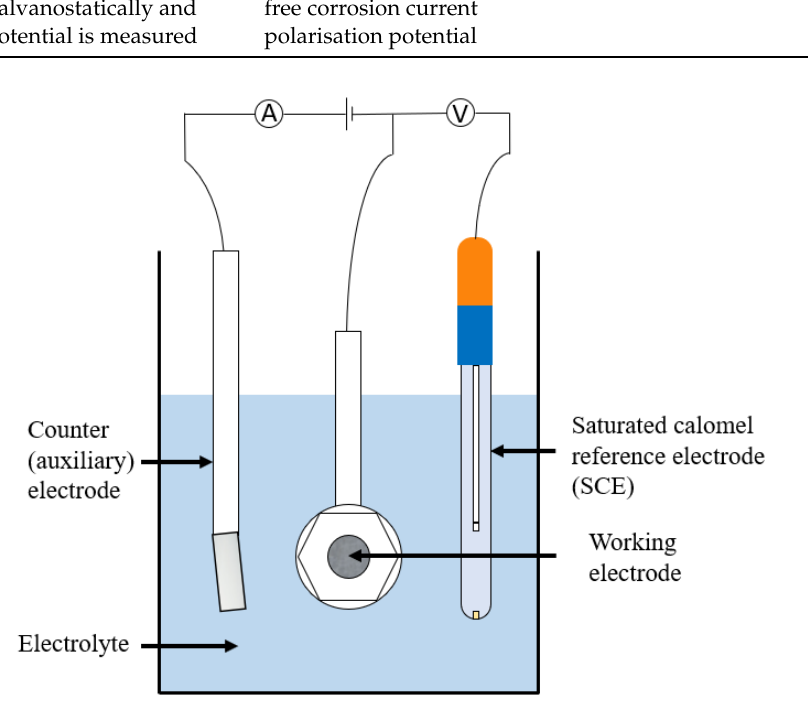
Figure 23. An example of a potentiodynamic experiment set up. Table 6. Potentiodynamic polarisation tests.